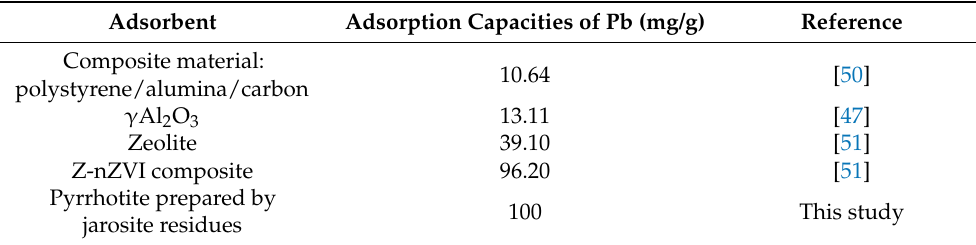
Table 2. Comparison of Pb removal with different adsorbents reported in the literature. Adsorbent Adsorption Capacities of Pb